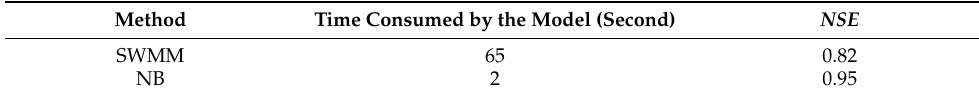
Table 4. Comparison between the SWMM and NB models.